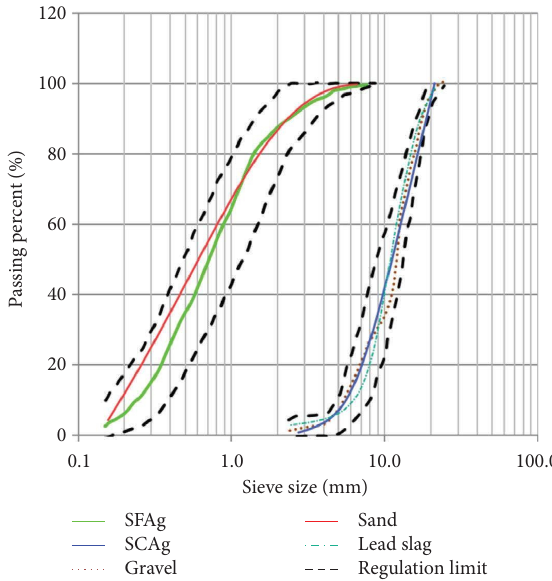
Figure 1: Grading curves of aggregates.